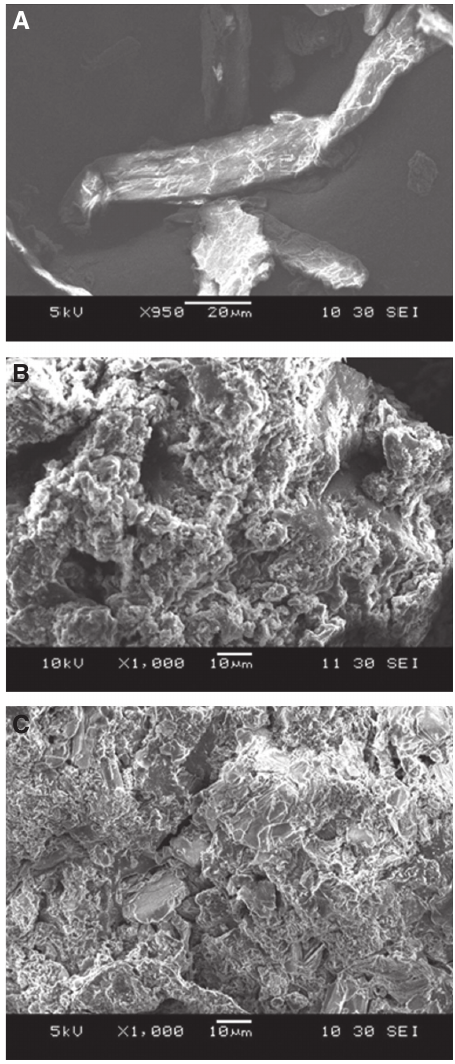
Figure 2 SEM characterization of feedstock and different catalysts. (A) commercially available untreated cellulose, (B) catalyst obtained from hydrothermal carbonization followed by sulfonation of the commercially available cellulose, (C) catalyst obtained from waste paper pretreated with ultrasonically assisted alkaline